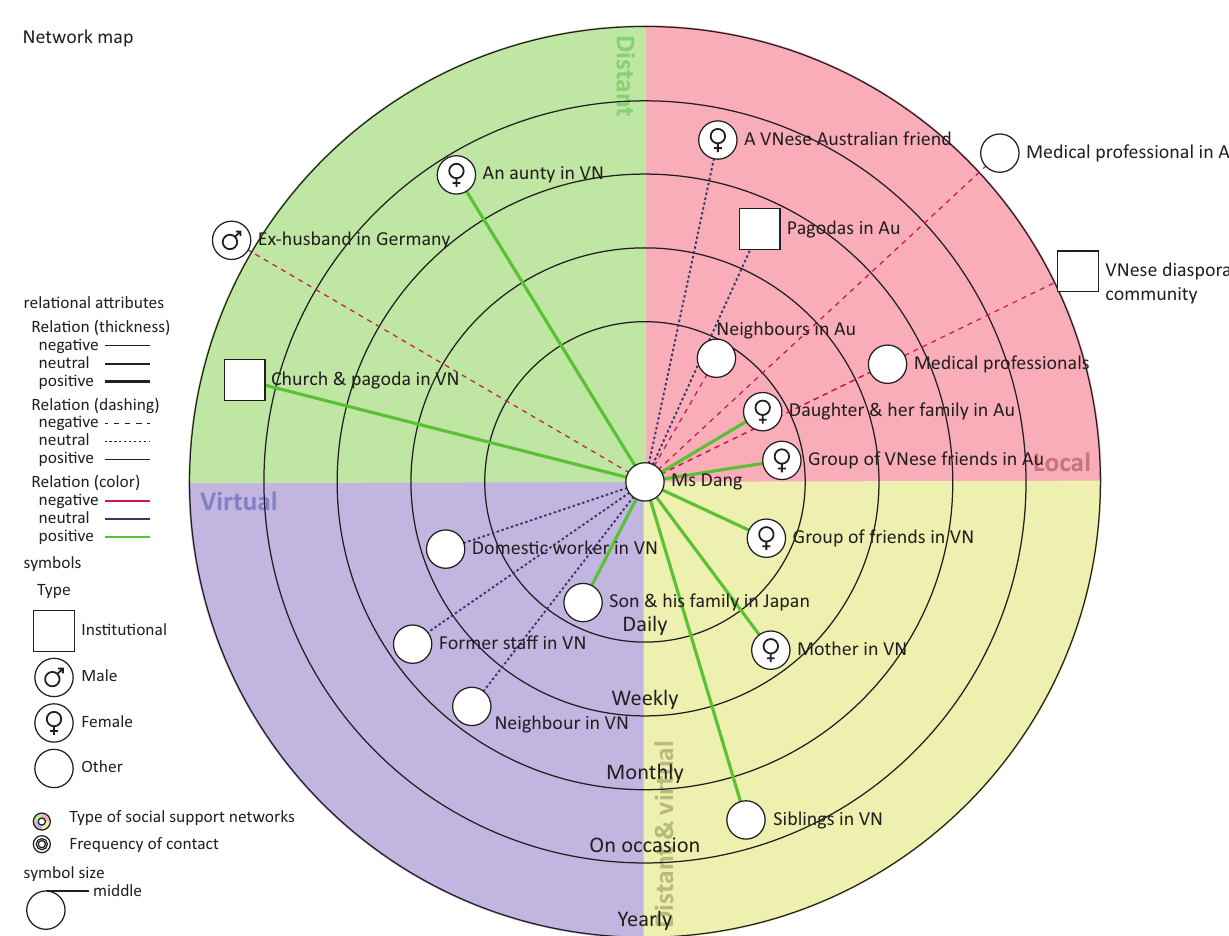
Figure 1. Illustration for digital kinning practices of a grandparent